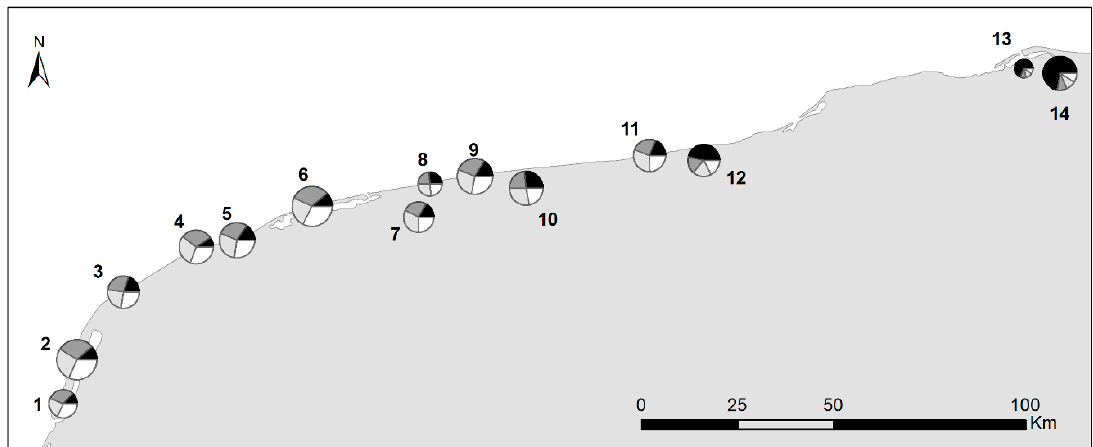
Figure 3. Assignment of sampling sites to four genetic groups identified in Structure Harvester (K = 4) of C. yucatanicus in the Yucatan Peninsula, Mexico. Sampling sites are as follows: (1) southwest Celestún, (2) northeast Celestún, (3) El Palmar, (4) west Sisal, (5) east Sisal, (6) Chuburná, (7) Capilla, (8) west Chixchulub, (9) San Benito, (10) Xcambó, (11) Santa Clara, (12) Dzilam, (13) west Ría Lagartos, and (14) east Ría Lagartos.